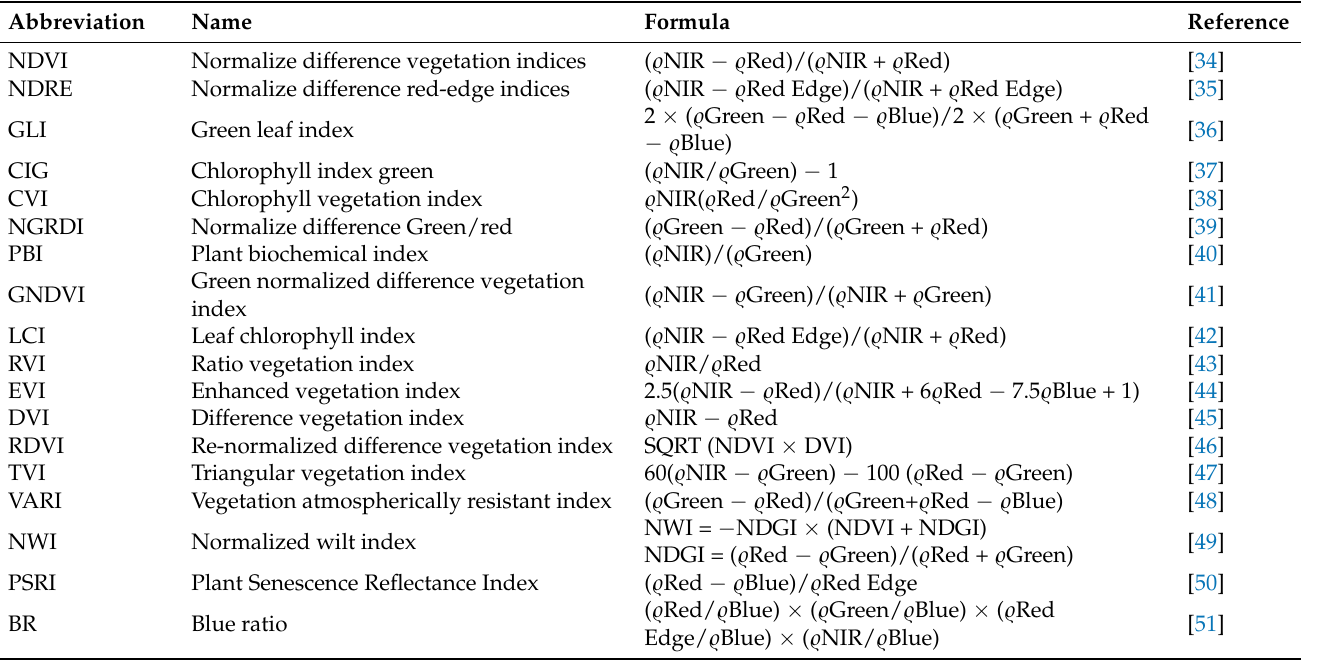
Table 2. Vegetation indices analyzed in this